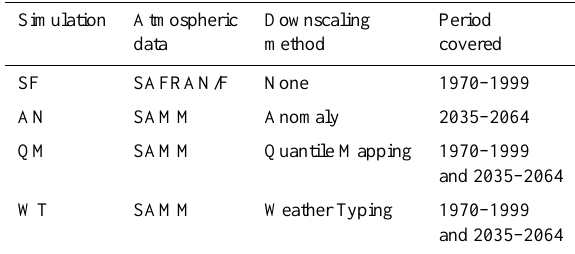
Table 1. Hydrological simulations run for this